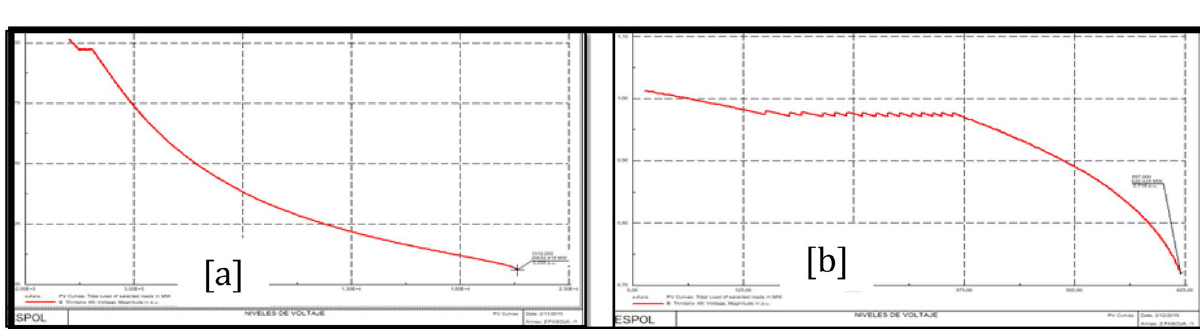
Figure 11. Stability PV before load model ( a ) and PV after load model ( b ) Caraguay 69 kV bus.